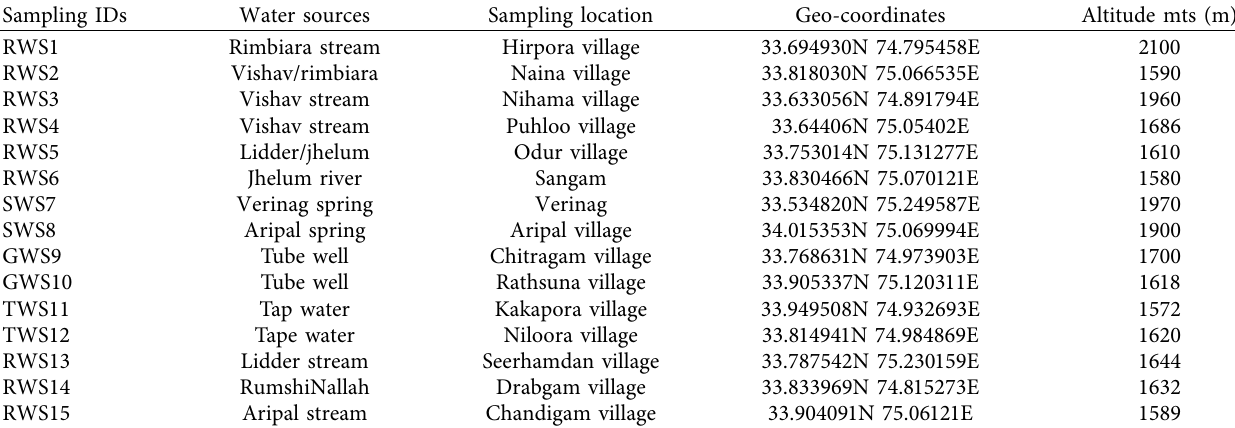
Table 2: Sampling sites description of south Kashmir drinking water sources. Sampling